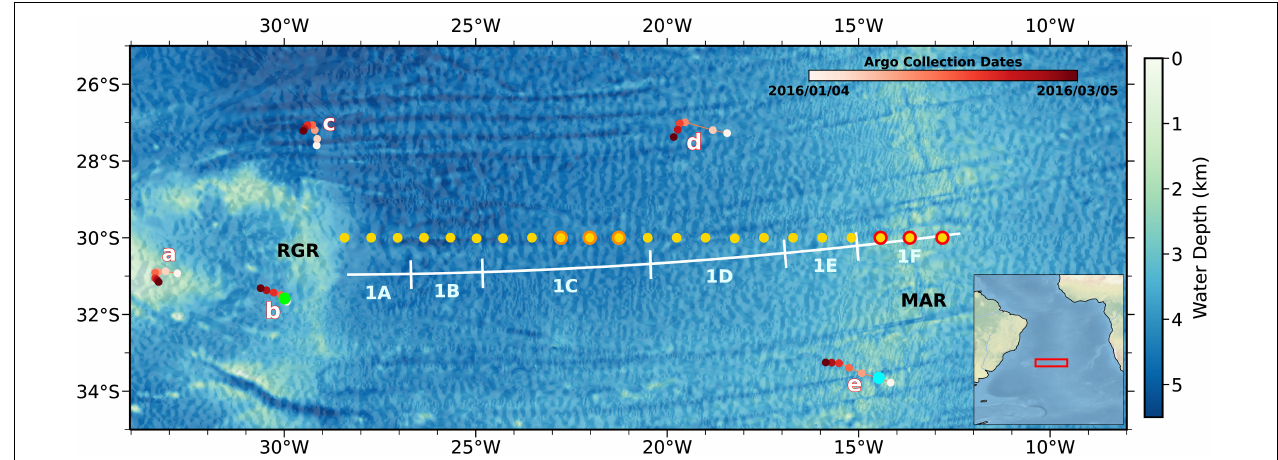
FIGURE 1 | Bathymetric map of seismic survey location. Bathymetry from the Global Multi-Resolution Topography Synthesis (Ryan et al., 2009). White lines = seismic profiles collected between January 29 and February 14, 2016, short meridional lines mark the connection point between zonal lines; yellow dots = CTD casts from GO-SHIP survey acquired in October 2011, yellow dots with orange/red edges correspond to orange/red profiles in Figure 2 (GO-SHIP 2003 CTDs within 0.5 ◦ of 2011 CTDs and are not shown); red dots = Argo float trajectories between January 4 and March 5, 2016, labeled a–e; green and cyan dots = Argo floats used for mixing calculation to compare with seismic results in Figure 6 . RGR, Rio-Grande Rise; MAR, Mid-Atlantic Ridge. Inset shows regional setting, with red box marking the location of the study